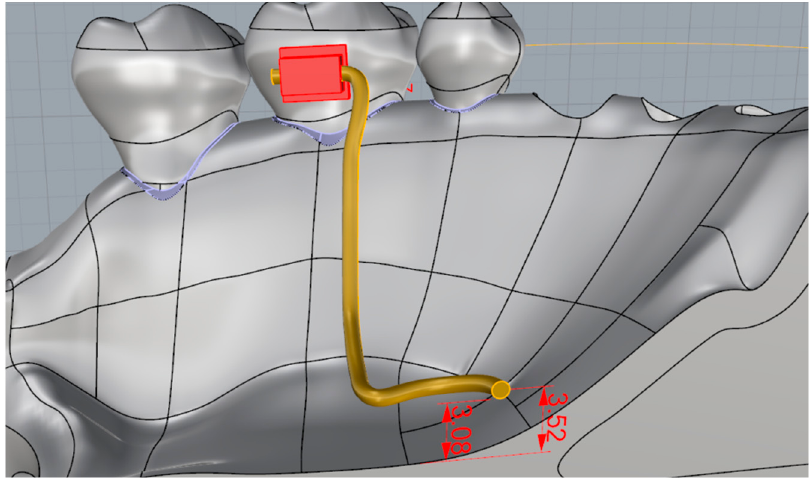
Figure 3. Position of the transpalatal bar in the